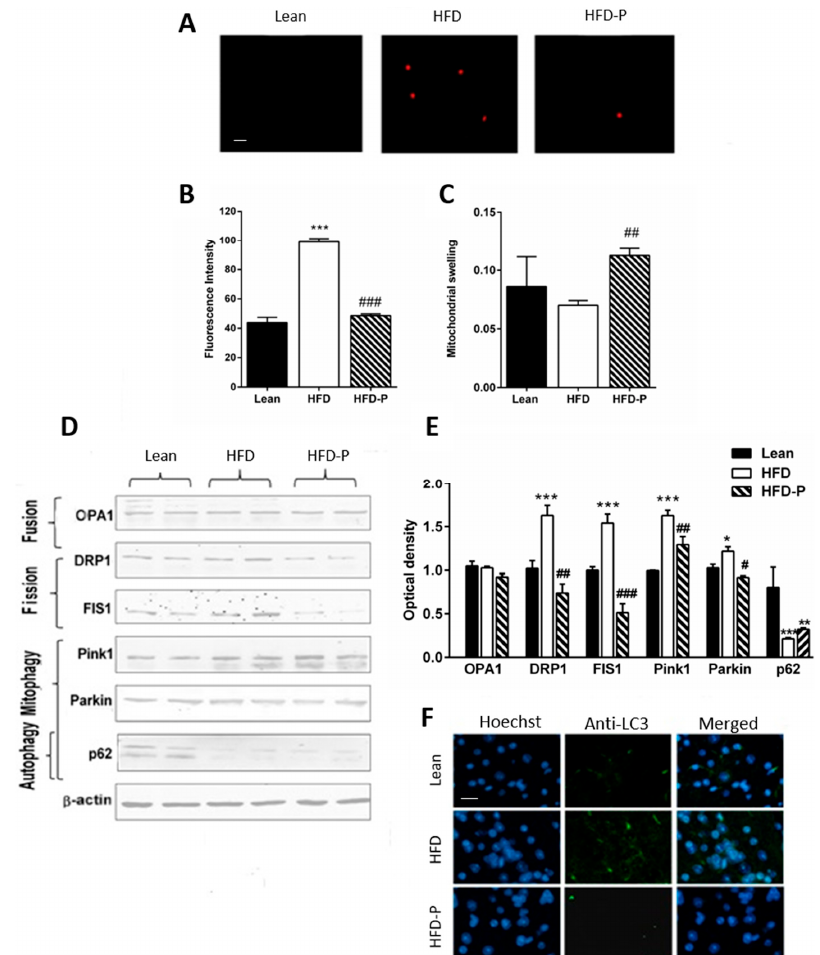
Figure 5. Pistachio intake counteracts HFD-induced mitochondrial dysfunction. ( A ) mitochondrial Figure 5. stress in enriched mitochondria fraction from lean, HFD, or HFD-P fed mice by MitoSox staining; ( B ) level of fluorescence intensity by MitoSox assay; ( C ) mitochondria swelling in lean, HFD, and HFD-P brains; ( D ) Western blot of proteins extracted from brains of lean, HFD, or HFD-P mice and incubated with antibodies against proteins involved in mitochondrial dynamics (OPA1, DRP1, and FIS1), and mitophagy (PINk1, Parkin, and p62). Uniformity of gel loading was confirmed with β -actin as standard. ( E ) densitometric analysis; ( F ) immunofluorescence of cerebral cortex sections of lean, HFD, or HFD-P mice incubated with anti-LC3. Data are the means ± SEM ( n = 8 / group). * p < 0.05, ** p < 0.01, *** p < 0.001 vs STD. # p < 0.05, ## p < 0.01, ### p < 0.001 vs HFD. Microscope magnification 40 × . Bar: 50 µ